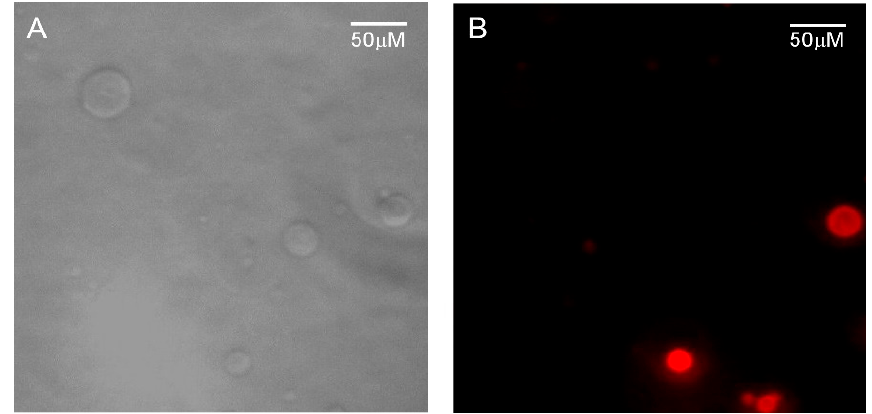
Figure 6. Microscopy images of DOPG GUVs in a mixture with DOPC-BODIPY GUVs obtained with ( A ) phase contrast and ( B ) upon excitation with Vis-light using the Leica DsRed filter (both images correspond to the same field).